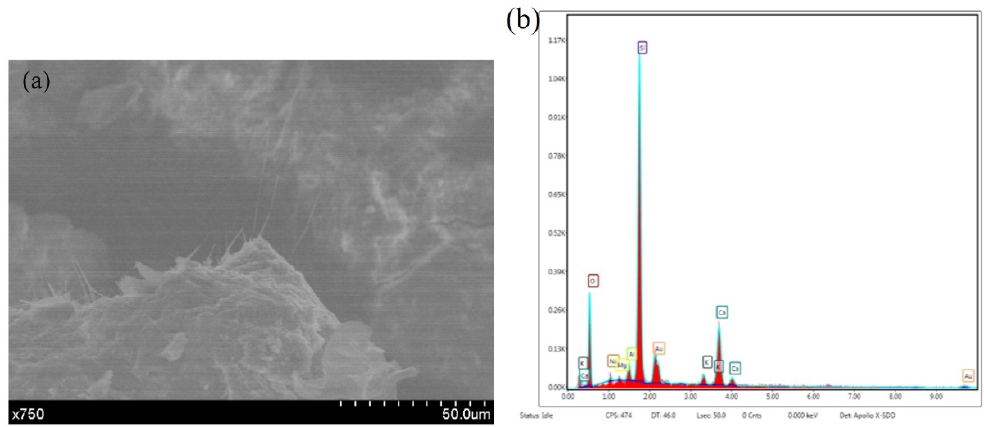
Figure 11. The micromorphology and EDS results of the cracks. ( a ) Micromorphology. ( b ) EDS results.